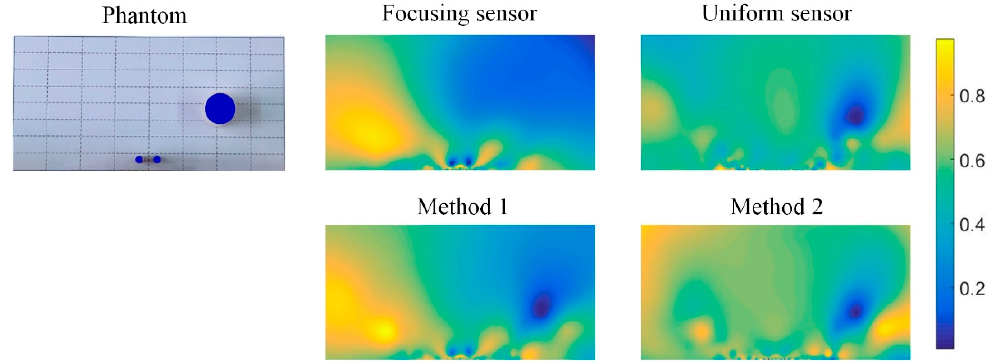
Figure 18. Experimental reconstructions from focusing sensor, uniform sensor, and two fusion methods.